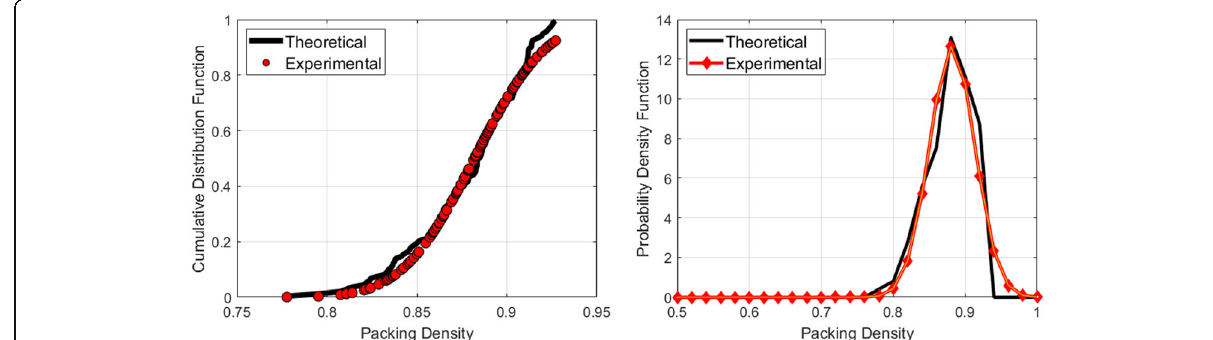
Fig. 2 Statistical Indentation Analysis; left - cumulative distribution functions (CDF), right – probability density function of packing